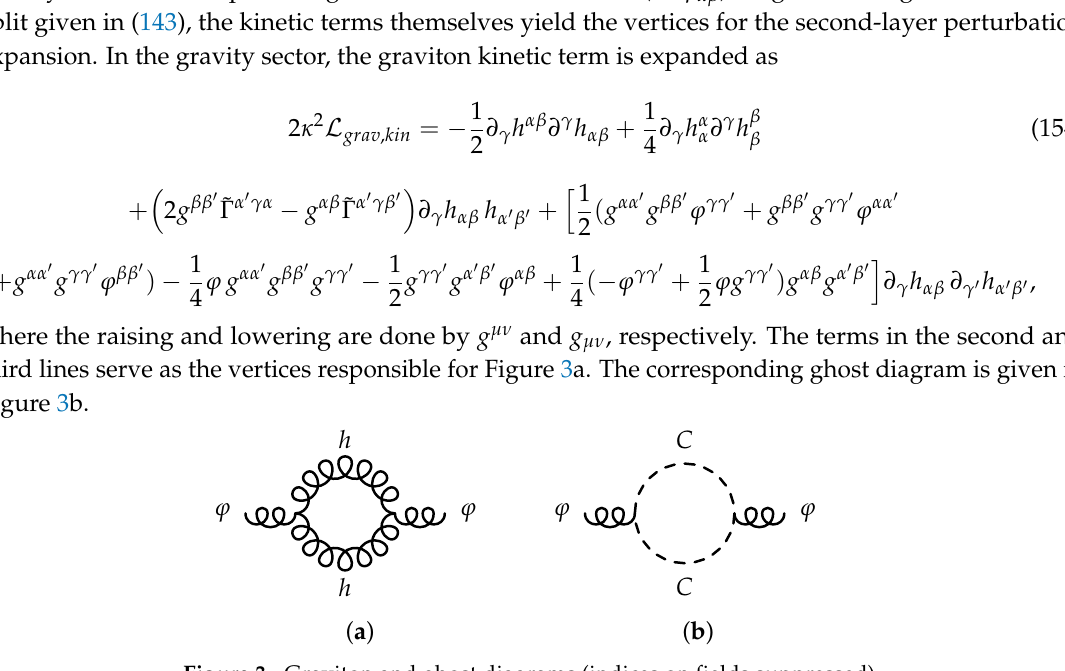
Figure 3. graviton and ghost diagrams (indices on fields suppressed)